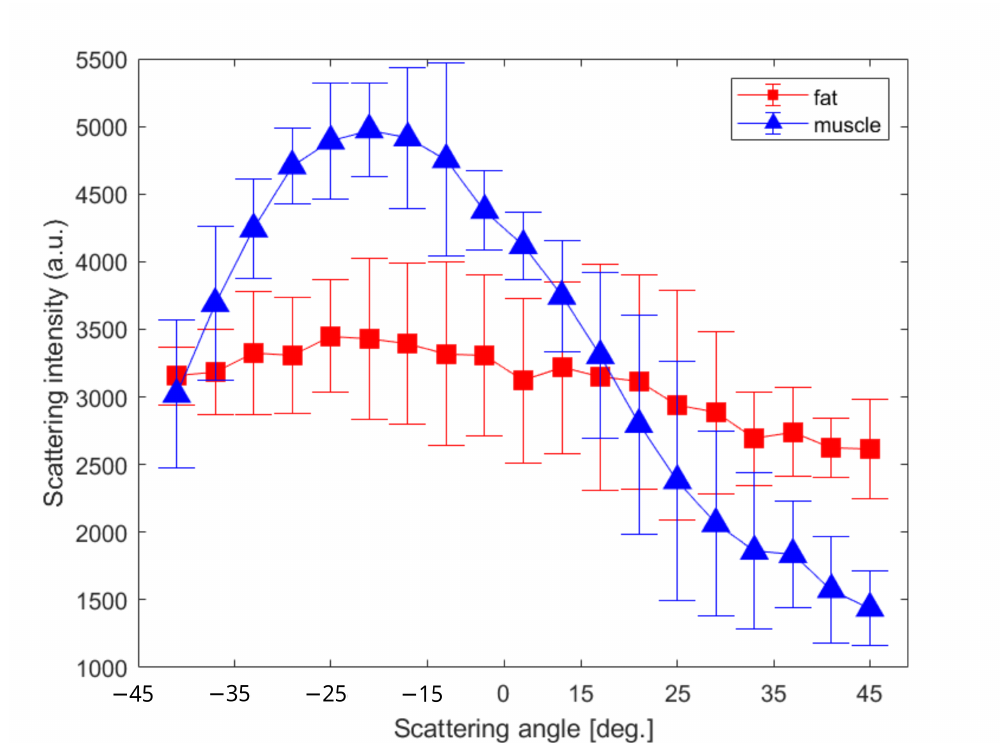
Figure 4. ( a ) Raw rabbit leg with the ROIs presented for the connective/muscular (red) and single muscular–tendon (blue) tissues. ( b ) Total polarized-resolved scattering intensity collected and averaged over each